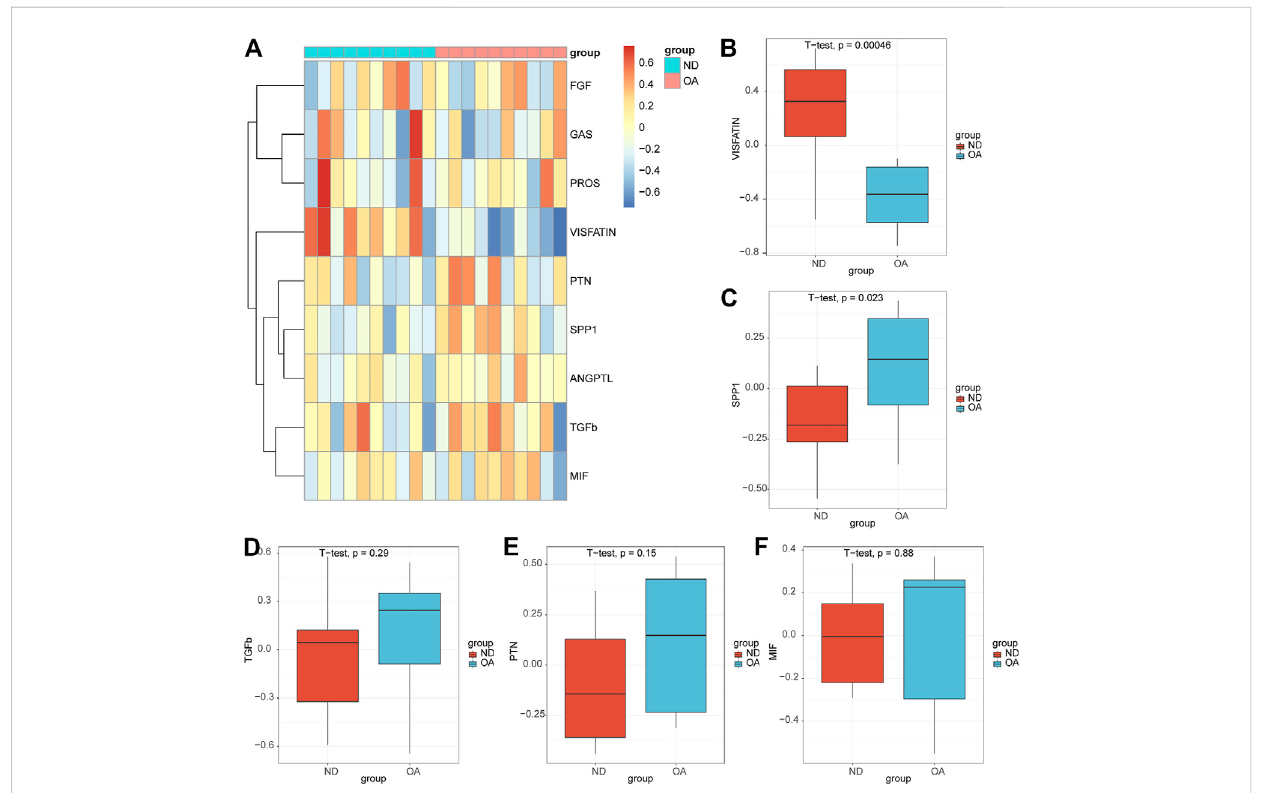
FIGURE 8 Validation of the pathways in the bulk rna-seq datasets. (A) Heatmap of the GSVA enrichment scores of the signaling pathways. Box plots of the enrichment scores of the VISFATIN (B) , SPP1 (C) , TGFb (D) , PTN (E) , MIF (F) signaling pathways. The t -test was used to compare the diferences between two groups. p -values < 0.05 indicated a statistically signifcant